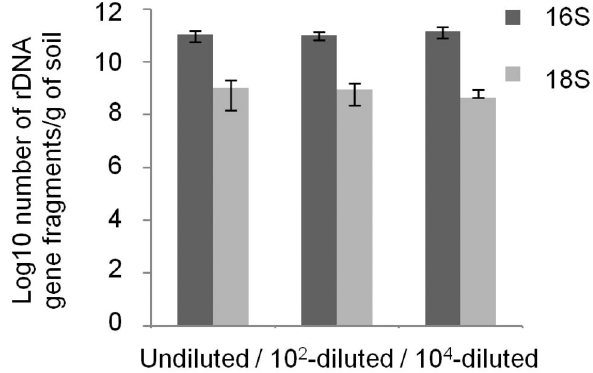
Figure 2. Abundance of 16S and 18S rDNA gene fragments in the constructed microcosms. The number of rDNA gene fragments were determined by real time quantitative PCR from a standard curve relating the quantity of rDNA fragments as a function of the Ct value. The errors bars represent standard deviation from three replicate samples value.